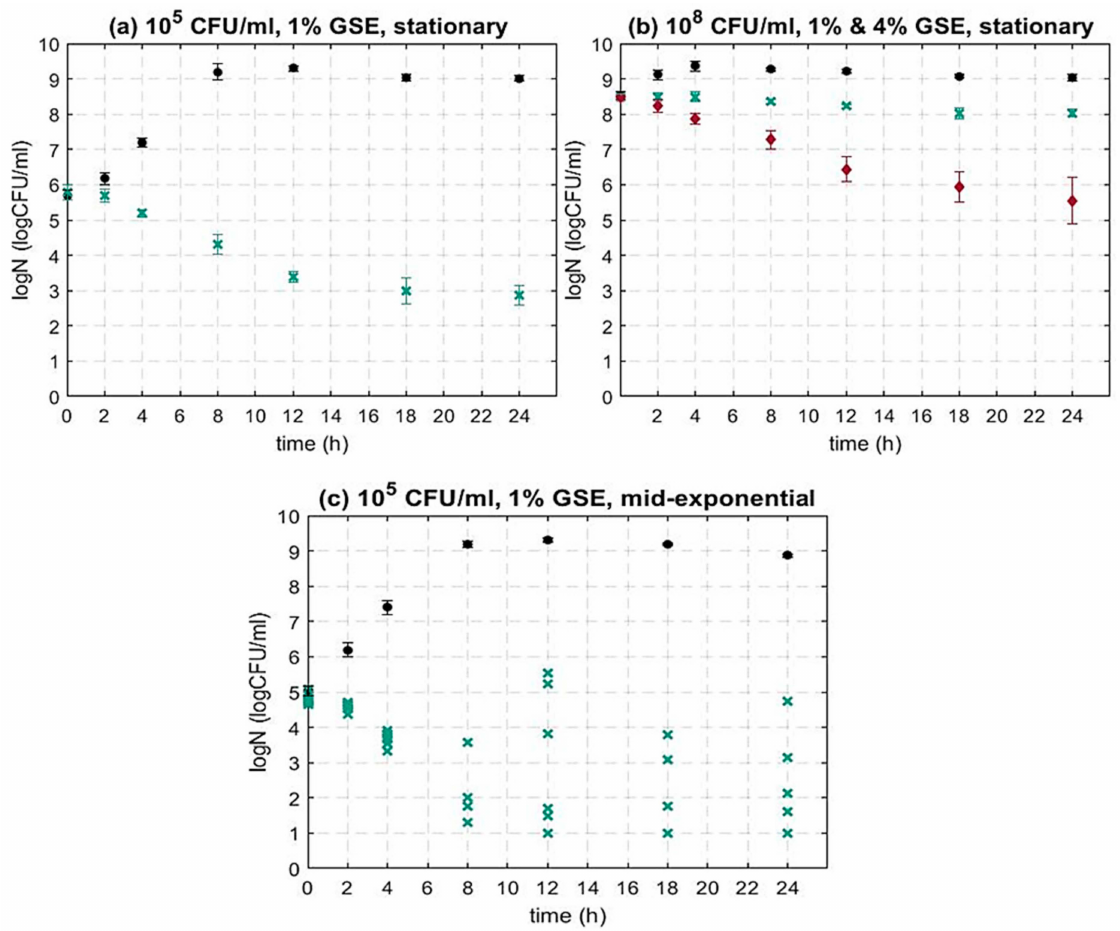
Figure 1. Inactivation dynamics of L. monocytogenes 10403S WT at initial inoculum concentration ( a ) 10 5 CFU/mL, stationary phase cells ( b ) 10 8 CFU/mL, stationary phase cells ( c ) 10 5 CFU/mL, mid- exponential phase cells. In all plots, ( • ) control (w/o GSE), ( × ) 1% GSE. In the ( b ) plot, ( (cid:7) ) 4% GSE. In ( a , b ), each time point represents the average of two independent experiments with three technical replicates per experiment. Error bars show standard deviation. In ( c ), all replicates (independent experiments) are presented due to high variation between